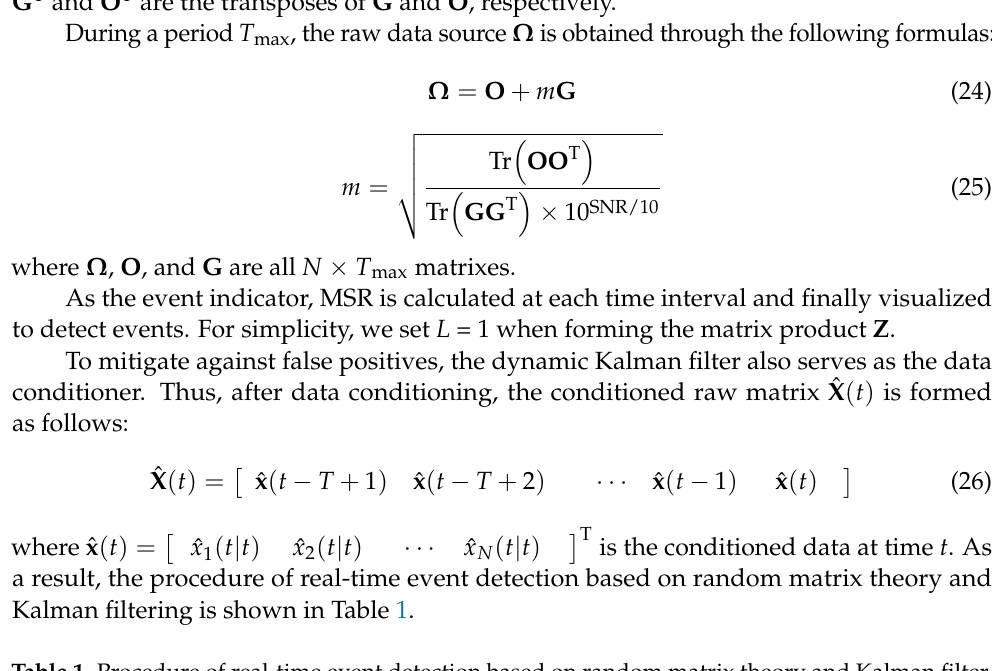
Table 1. Procedure of real-time event detection based on random matrix theory and Kalman filter- ing [30]. (Reproduced with permission from Fujia Han, IEEE Proceedings; published by IEEE 2018.).